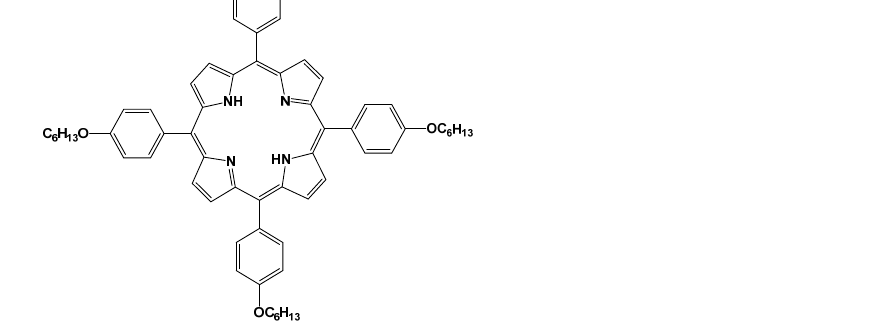
Figure 1. Molecular structure of 5,10,15,20-tetrakis(4- n -hexyloxyphenyl)porphyrin. Film samples of PLA–TPP4 ОС 6 with a diameter of 90 mm and a thickness of 100–120 µm were obtained by casting from a solution (Scheme 1). The solvent was chloroform (Vekton, Russia). PLA was dissolved in chloroform and heated to a temperature of 59 ± 1 °C. After cooling the PLA solution to 35–38 °C, the porphyrin solution was added. The resulting solution was mixed and poured into Petri dishes. The content of TPP4OC 6 por- phyrins in the film composites was 0.2–0.5 wt %.